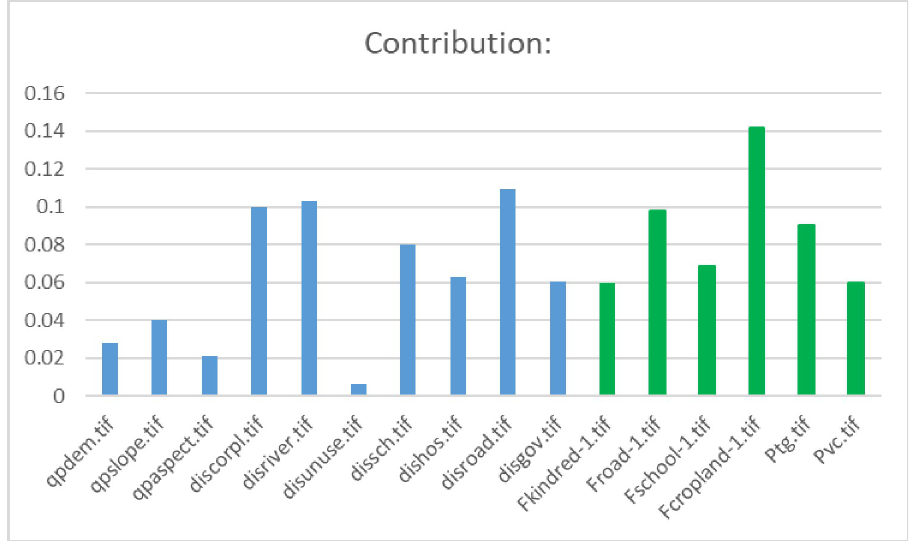
Fig 11. Contribution of each driving factor to the expansion of rural settlement land. (Software: OriginPro 2017C SR2, https://www.originlab.com/).